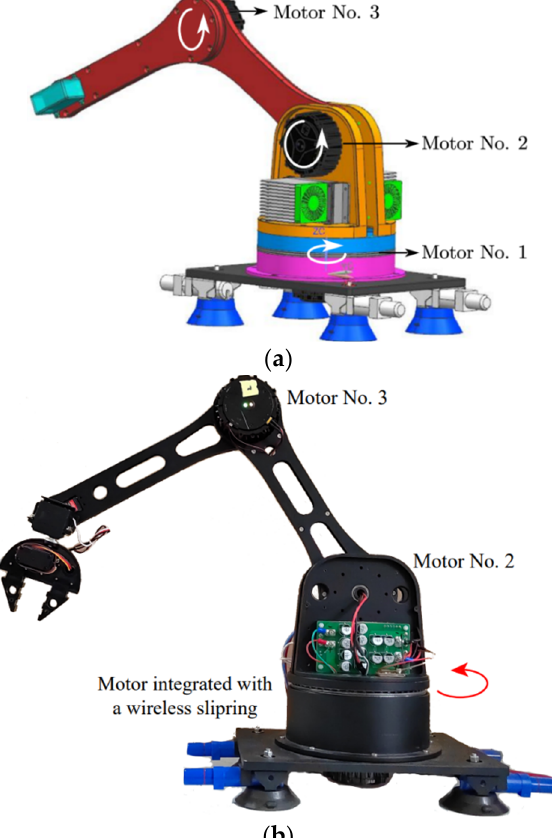
Figure 14. ( a ) 3D structure and ( b ) experimental prototype of the three-axis robot manipulator.